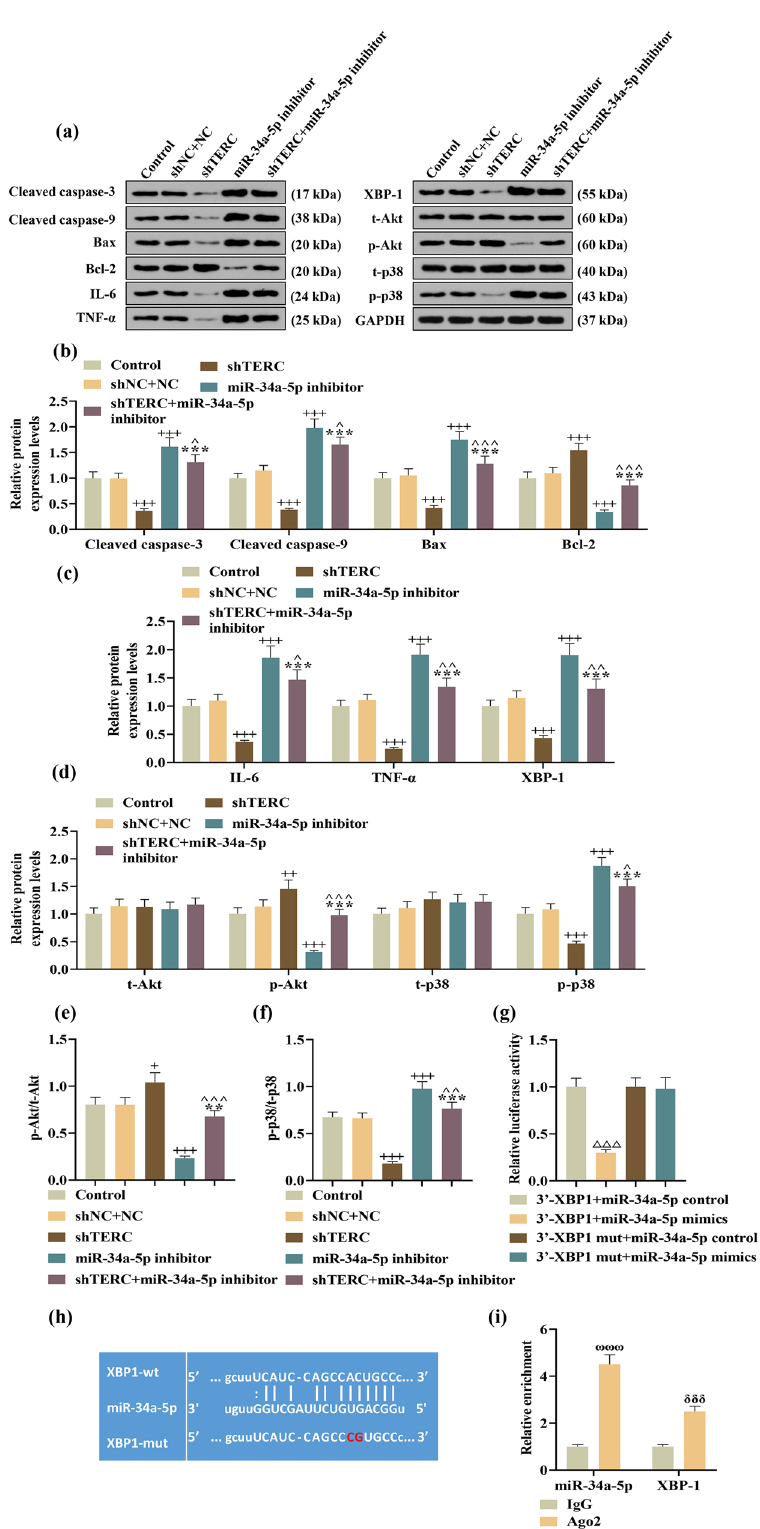
Figure 5: Knockdown of TERC inhibited apoptosis, in fl ammation, and p38 activation yet activated Akt in LPS - induced PC - 12 cells via the miR - 34a - 5p/XBP - 1 axis. ( a – f ) The expressions of cleaved caspase - 3, cleaved caspase - 9, Bcl - 2, Bax, IL - 6, TNF - α , XBP - 1, t - Akt, p - Akt, t - p38, p - p38, p - Akt/t - Akt, and p - p38/t - p38 in miR - 34a - 5p inhibitor and/or shTERC - transfected PC - 12 cells after LPS treatment were analyzed by Western blot, with GAPDH serving as a control gene. ( g – i ) . The interaction between miR - 34a - 5p and XBP - 1 was checked by ( g ) dual - luciferase reporter assay, predicted by ( h ) TargetScan V7.2, and rea ffi rmed by ( i ) RIP assay. + P or ^ P < 0.05; ^^ P or ++ P < 0.01, +++ P or *** P or ^^^ P or ΔΔΔ P or < 0.001, δδδ P < 0.001; ωωω P < 0.001; + vs shNC + NC; * vs shTERC ; ^ vs miR - 34a - 5p inhibitor; Δ vs 3 ′ - XBP1 + miR - 34a - 5p control; ω vs IgG in miR - 34a - 5p; δ vs IgG in XBP -